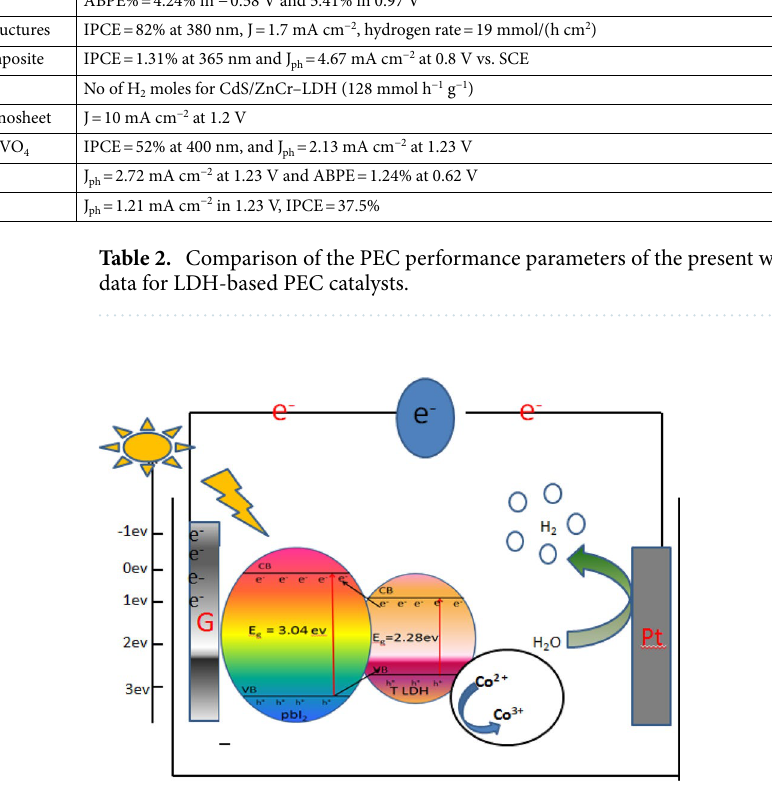
Figure 14. Energy level between T-LDH and PbI 2 in T-LDH/PbI 2 NC nanocomposite for PEC water